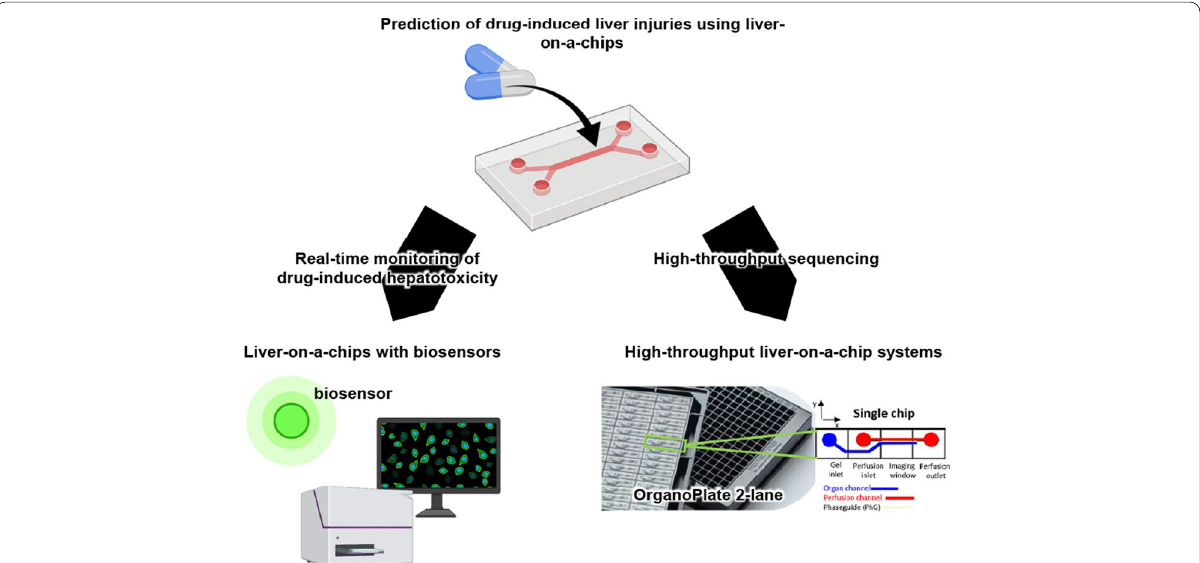
Fig. 2 Study of drug-induced liver injuries using liver-on-a-chips. To perform real-time monitoring of drug-induced toxicities, liver-on-a-chips containing biosensors that detect cytotoxicity have been developed. To perform drug screenings, a high-throughput liver-on-a-chip system was generated. Created with Biore nder. com. Adapted with permission under a Creative Commons CC BY 4.0 License from from ref [21]. Copyright 2021